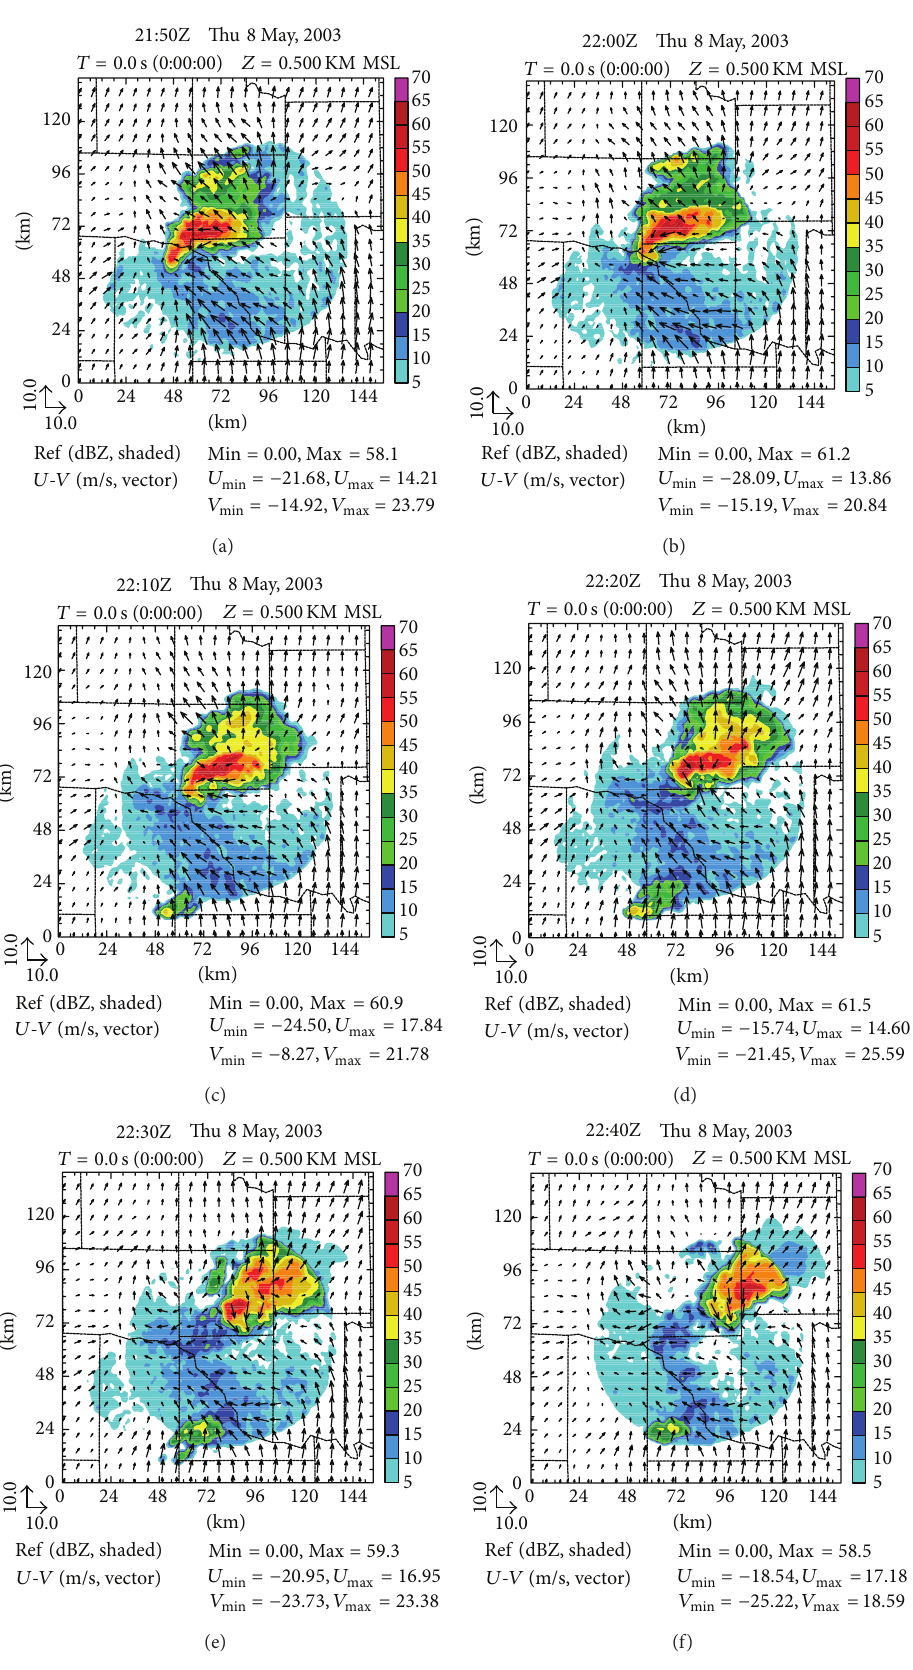
Figure 5: 0.5 km radar reflectivity and horizontal wind vectors from the control analysis from (a) 2150 UTC to (f) 2240 UTC at 10-minute